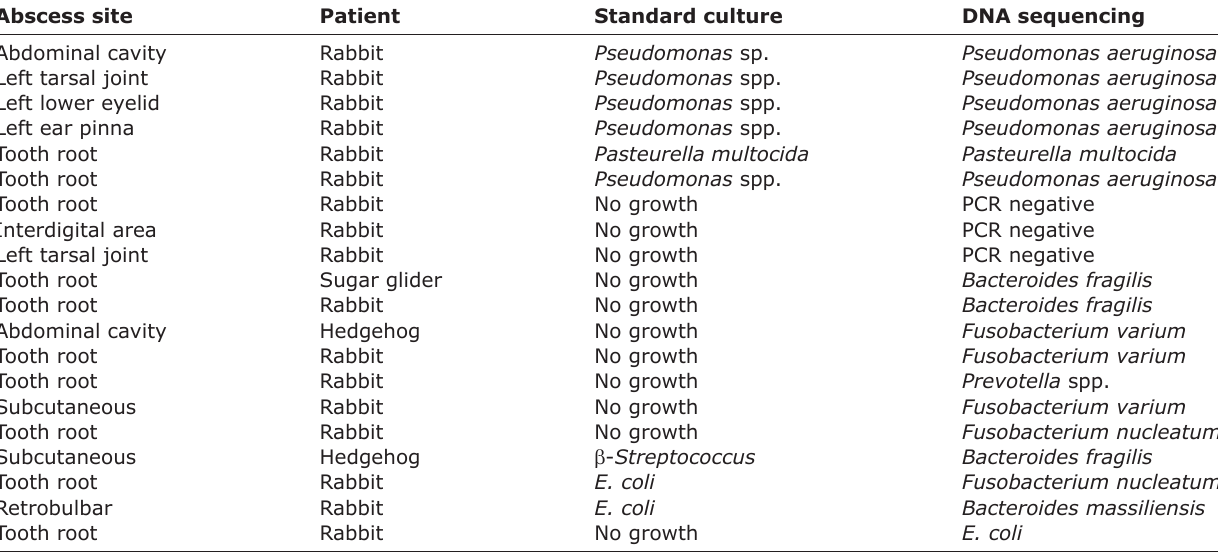
Table-1: Classification of the PCR results compared with conventional culture results from 20 cases of abscesses. Abscess